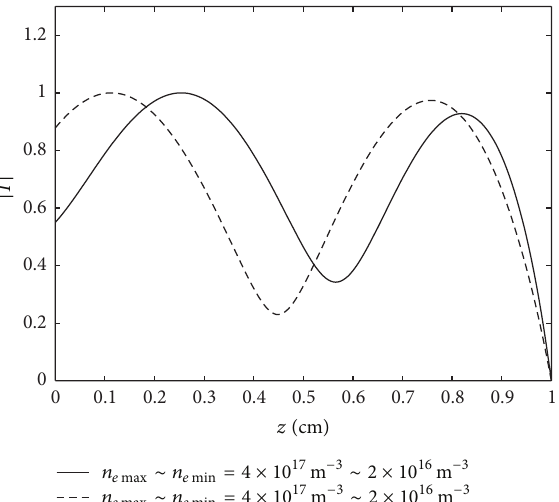
Figure 3: Current distribution along the plasma antenna.